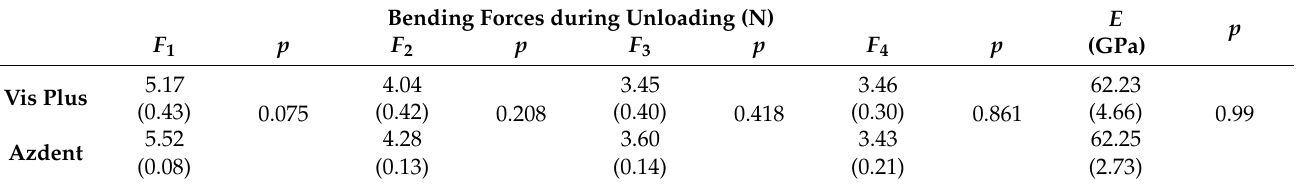
Table 7. Determined three-point bending test parameters of NiTi products: unloading forces ( F 1 , F 2 , F 3 , F 4 ), flexural modulus of elasticity E (standard deviation) and statistical analysis result p values. Bending Forces during Unloading